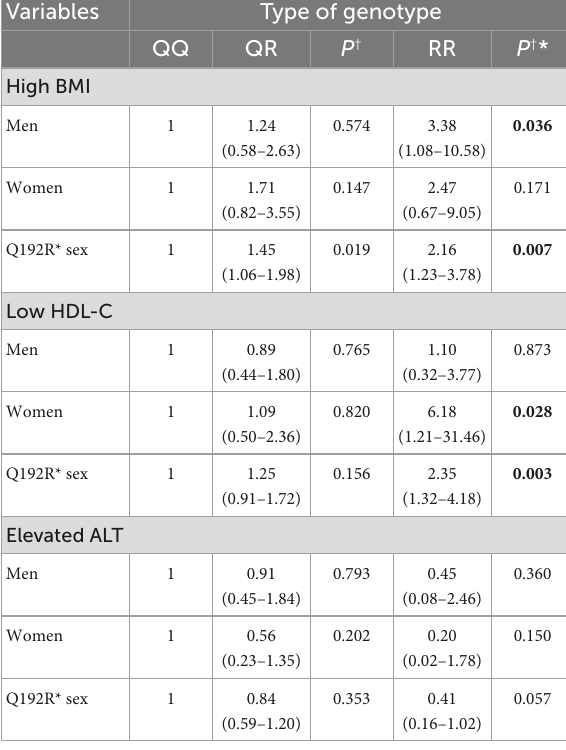
Valuesarereportedasoddsratioand95%confidenceinterval. † Obtainedfromlogisticregression. *Model is adjusted for physical activity, age, smoking status, medication used (antihypertension drugs, antidiabetic drugs, and antihyperlipidemic drugs), alcohol consumption, and BMI (for high BMI, all mentioned confounders were adjustedexceptBMI).